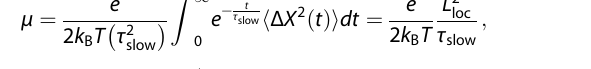
is indicated as red MN